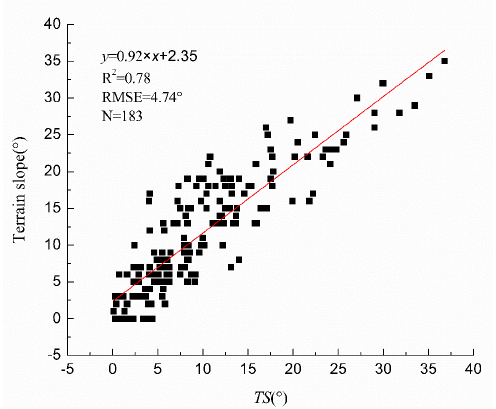
Figure 4. Scatter plot of TS and terrain slope